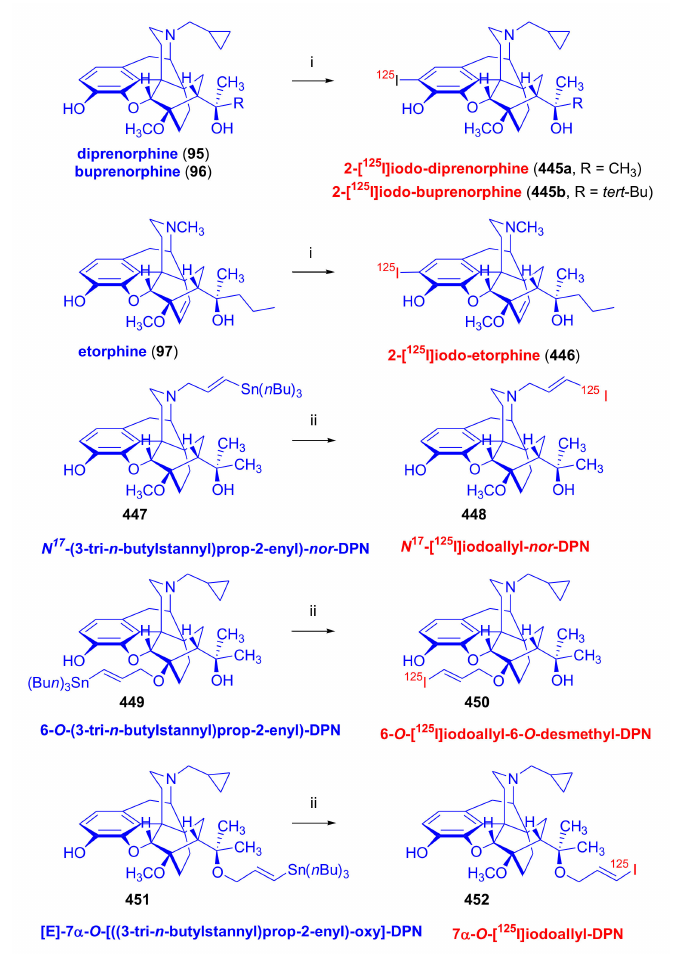
Figure 112. Synthesis of 125 I-labeled orvinol derivatives. Reagents and conditions : (i) [ 125 I]NaI, iodogen; (ii) [ 125 I]NaI, chloramines-T, AcOH, MeOH, room